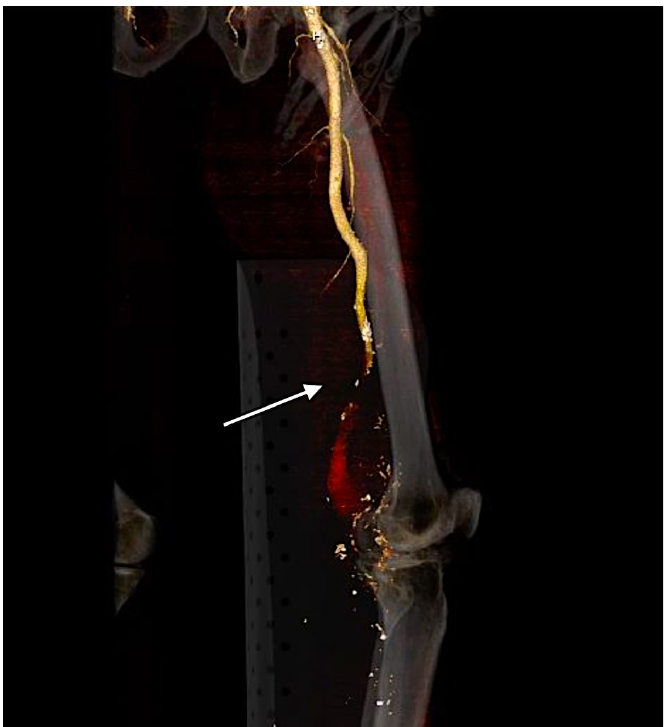
Image 1. Computed tomography angiography volume-rendering technique reconstruction of the left lower extremity in sagittal view demonstrating superficial artery occlusion with popliteal artery aneurysm rupture (arrow) and lack of arterial contrast enhancement distally.